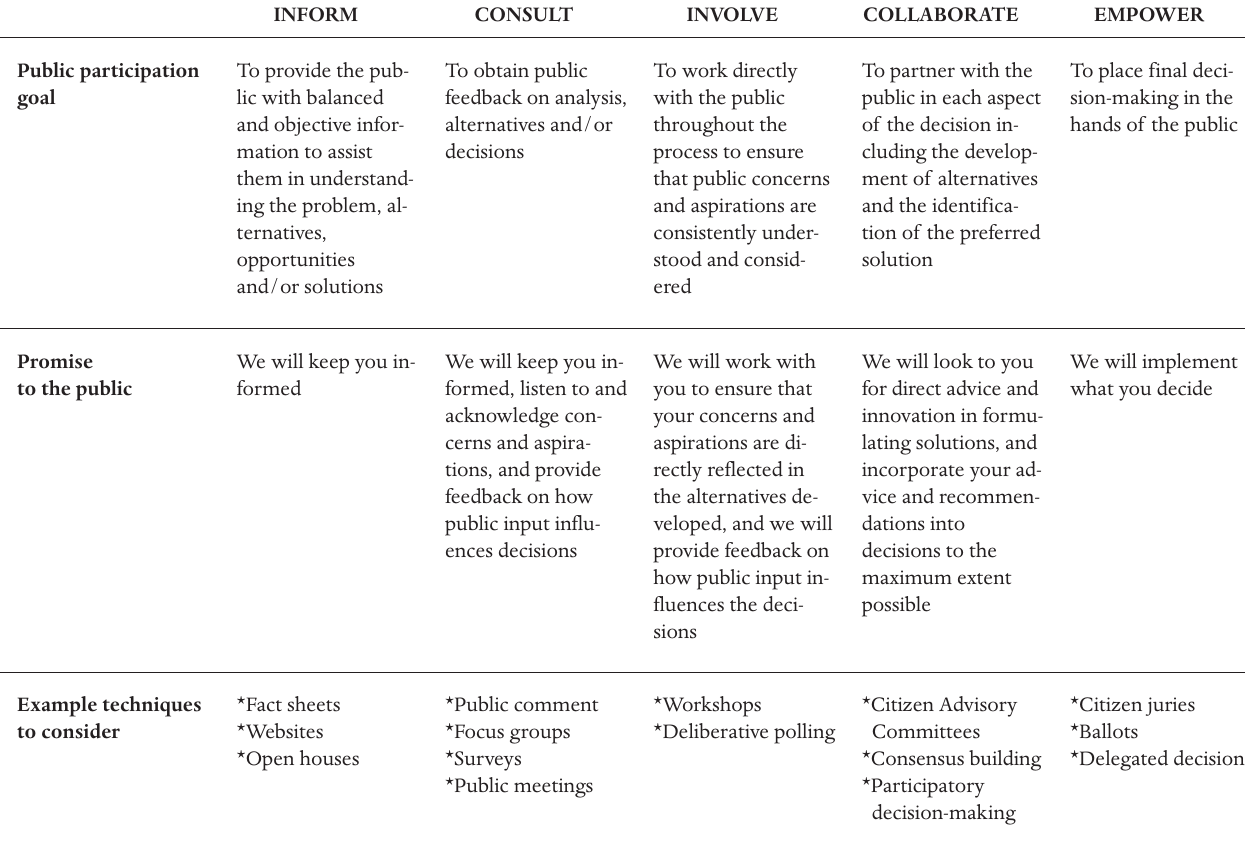
Table 1. The spectrum of public participation levels, as developed by the International Association for Public Participation